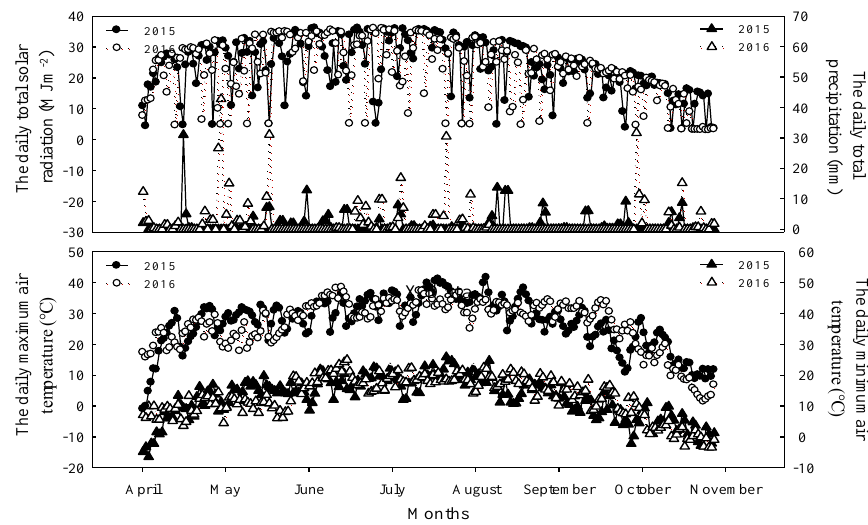
Figure 1. The daily total solar radiation (MJ m − 2 ), total precipitation (mm), maximum and minimum air temperature ( ◦ C) during cotton growing season in Shihezi